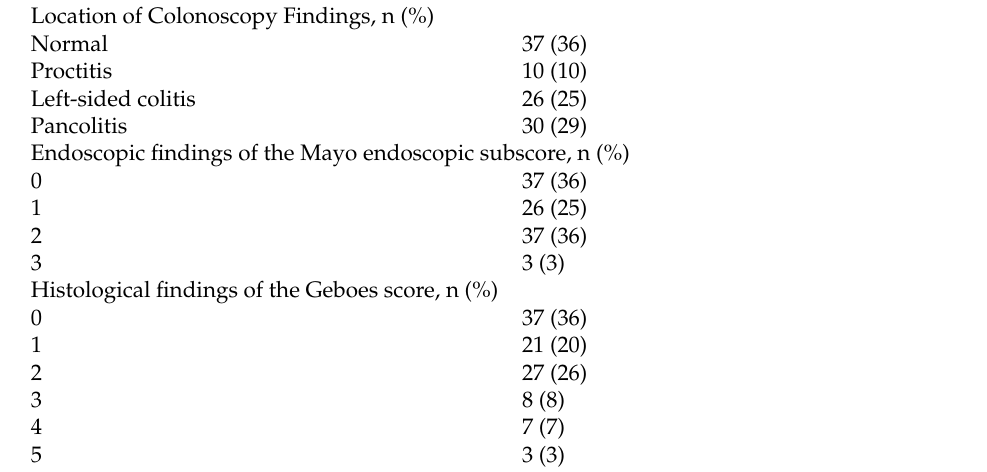
Table 2. Enrolled subjects’ endoscopic findings and histological findings (n = 103).